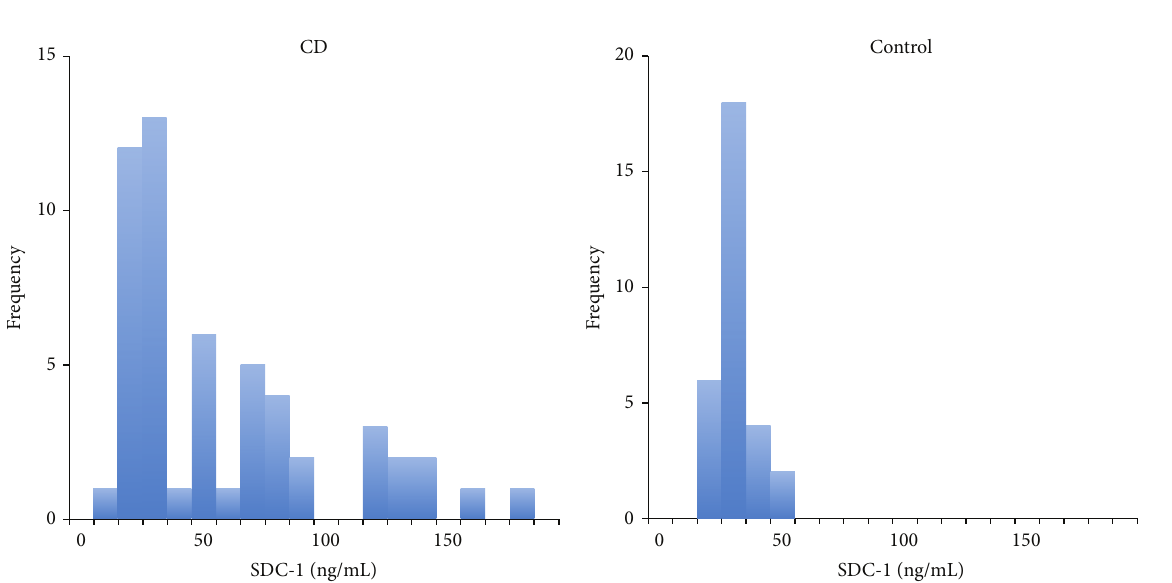
A strong positive correlation was found between SDC-1 and CRP ( 𝑟 = 0.687 , 𝑝 < 0.001 ) and the SDC-1 and CDAI ( 𝑟 = 0.747 , 𝑝 < 0.001 ) in a Pearson correlation analysis conducted between SDC-1 and CRP and